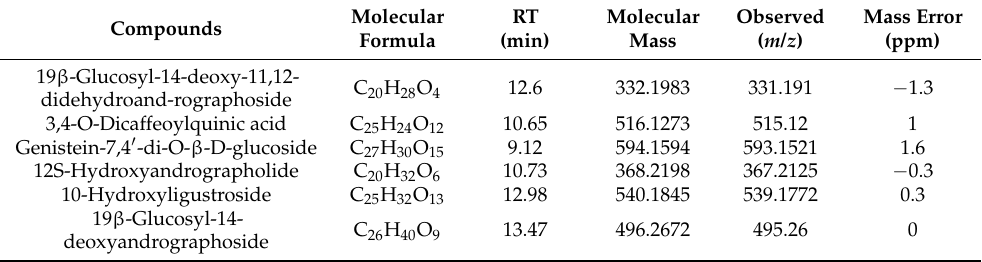
RT stands for “retention